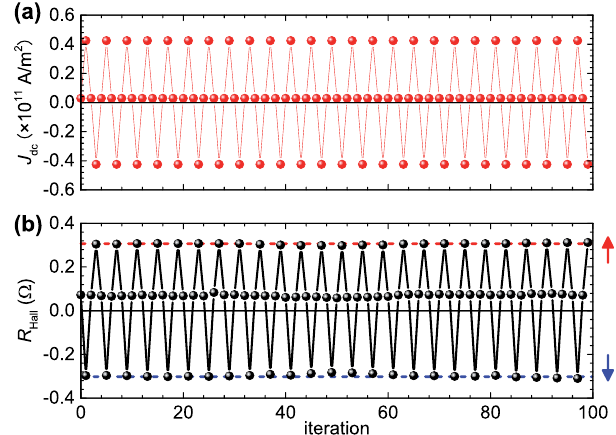
Figure 5. Alternative domain state switching. ( a ) Sequence of pulsed J dc injection. J dc s of + 0.4 × 10 11 , + 2.8 × 10 9 , and − 0.4 × 10 11 A/m 2 are repeatedly injected into the device. The pulse duration of each J ( b ) Monitored R Hall during alternative J dc injection. Dashed lines indicate the saturation values of R Hall in single domain